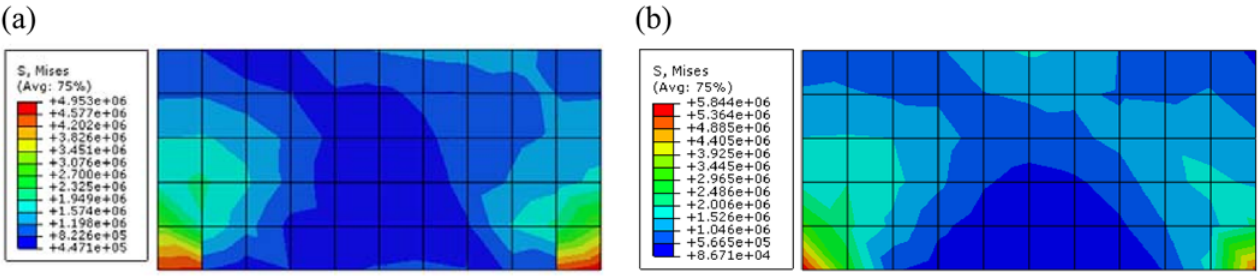
Fig 14. The Mises stress contour of the green region of the rectangle foundation calculated by different constitutive models(Pa) ((a)The Mises stress contour calculated by proposed constitutive model; (b)The Mises stress contour calculated by ubiquitous-joint